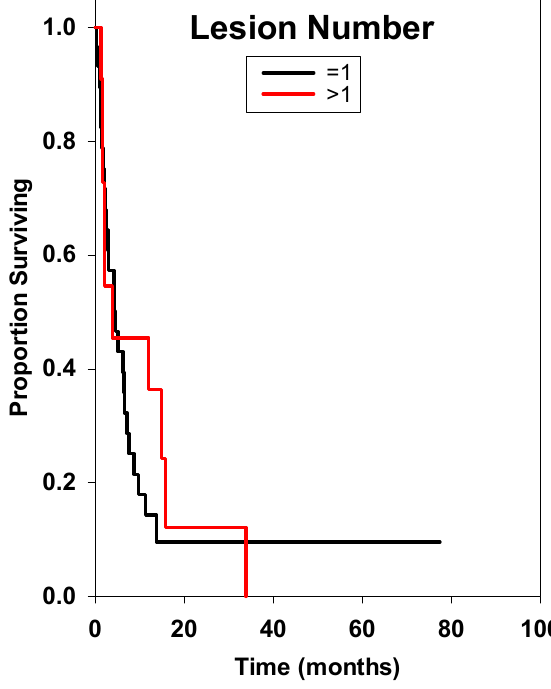
Figure 5. Survival curve considering the number of metastasis. There was no statistically significant difference between these two